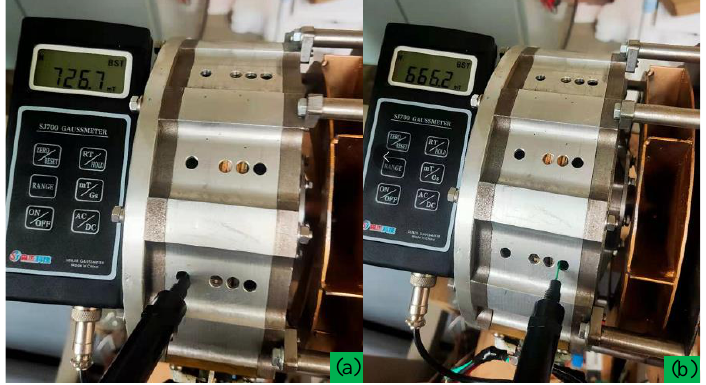
is inserted into the air gap to measure its magnetic field strength magnitude of PM as